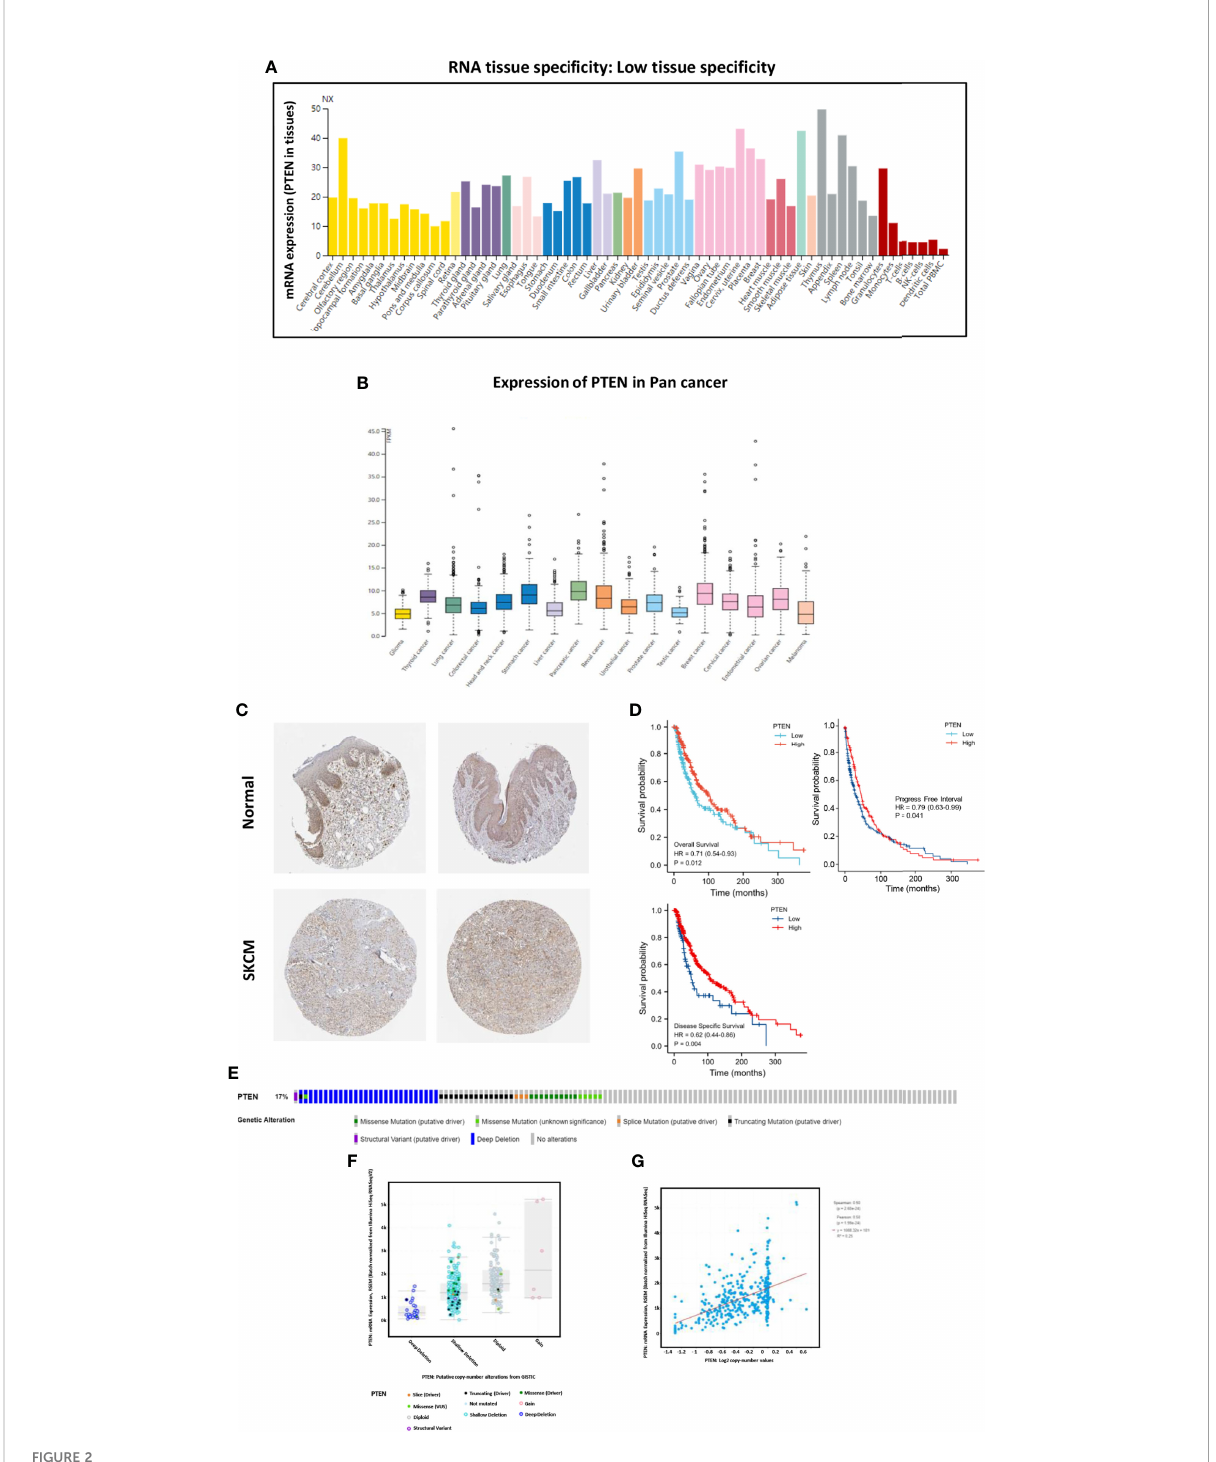
FIGURE 2 The tumor suppressor role of PTEN in SKCM. (A) Expression speci fi city of PTEN in various human tissues. (B) Expression distribution of PTEN in para-cancer patients. (C) Validation of the expression of PTEN at translational level using the Human Protein Atlas database (i.e., as determined by immunohistochemical staining). (D) Analysis of the relationship between the expression level of PTEN and patient survival rate, including overall survival, progress free interval, and disease speci fi c survival. (E) Distribution of PTEN genomic alterations in SKCM according to The Cancer Genome Atlas (TGCA) database displayed as a cBioPortal OncoPrint plot. The relationship between PTEN copy number and mRNA expression are shown in the dot plot (F) and correlation plot (G) ; they are all positively